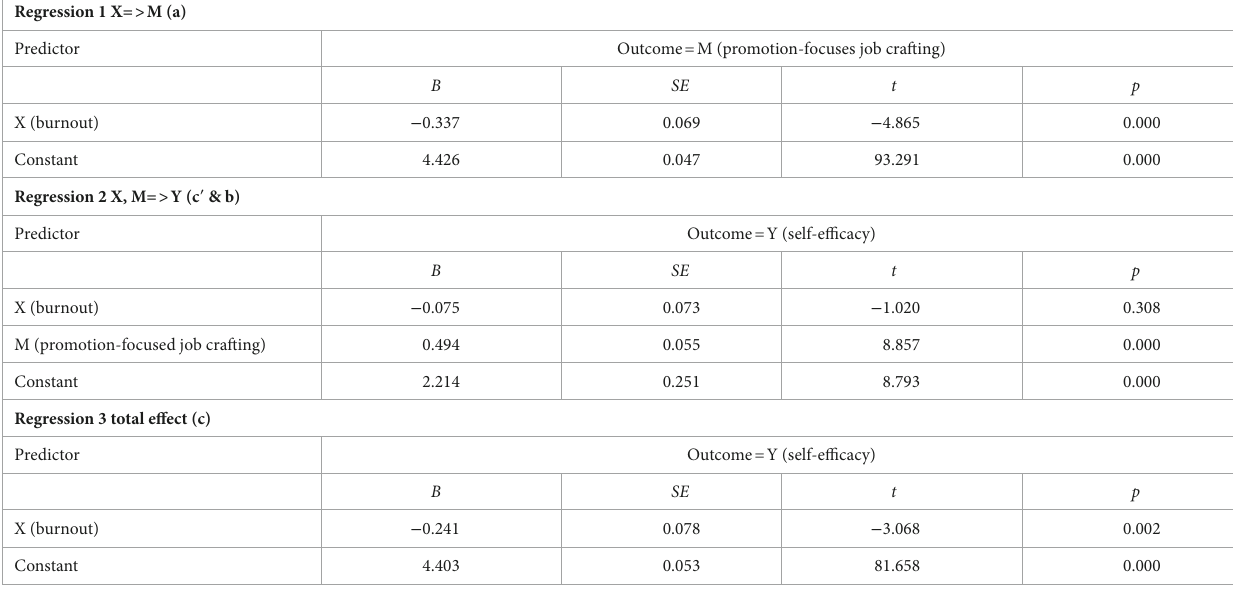
TABLE 3 Analysis of promotion-focuses job crafting mediation on the influence of burnout on self-efficacy (simple mediation model for promotion- focuses job crafting). Regression 1 X= > M (a) Predictor